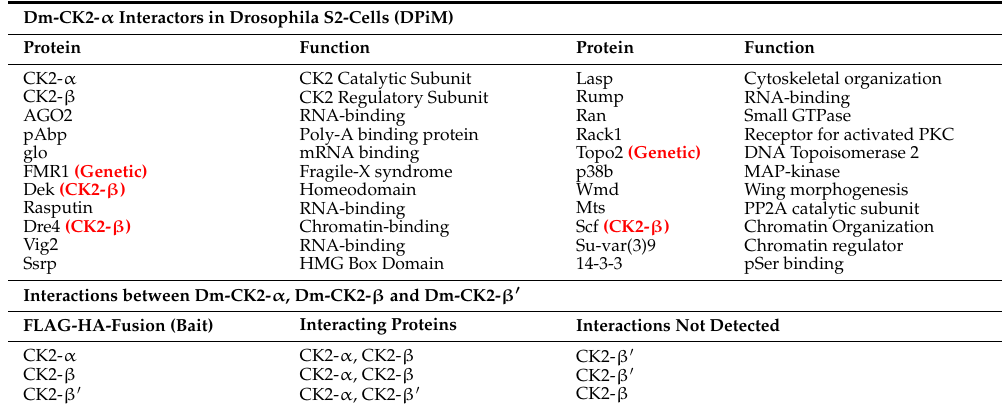
Table 3. The DPiM database reveals novel insights into the Dm-CK2